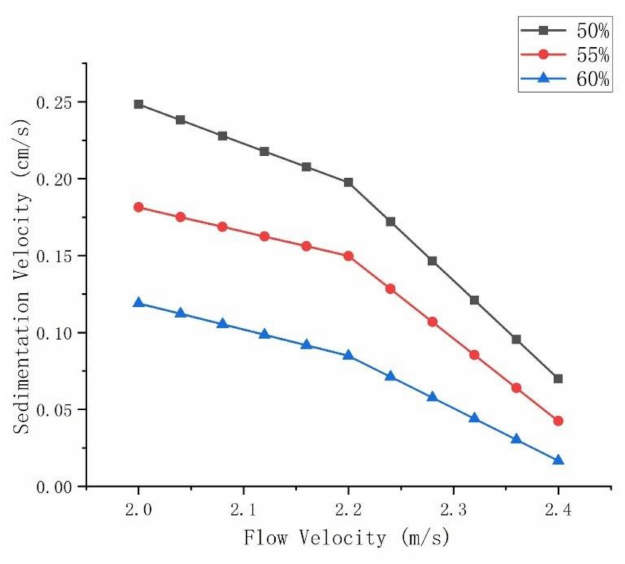
Figure 10. Relationship between the flow velocity and sedimentation velocity.